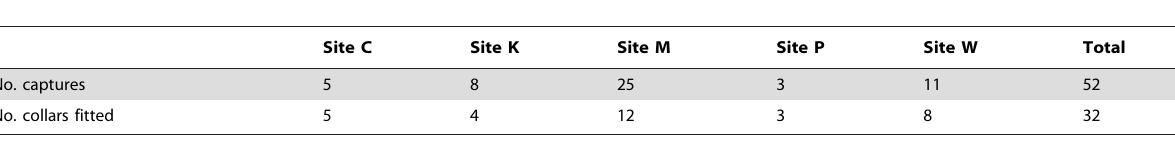
Table 1. Number of squirrel gliders captured/collared at each